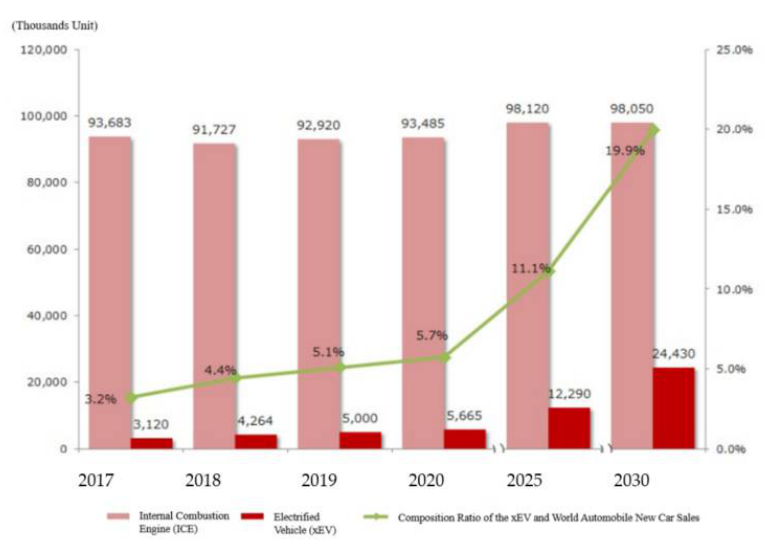
Figure 15. World automobile new car sales transition by different powertrain [73].